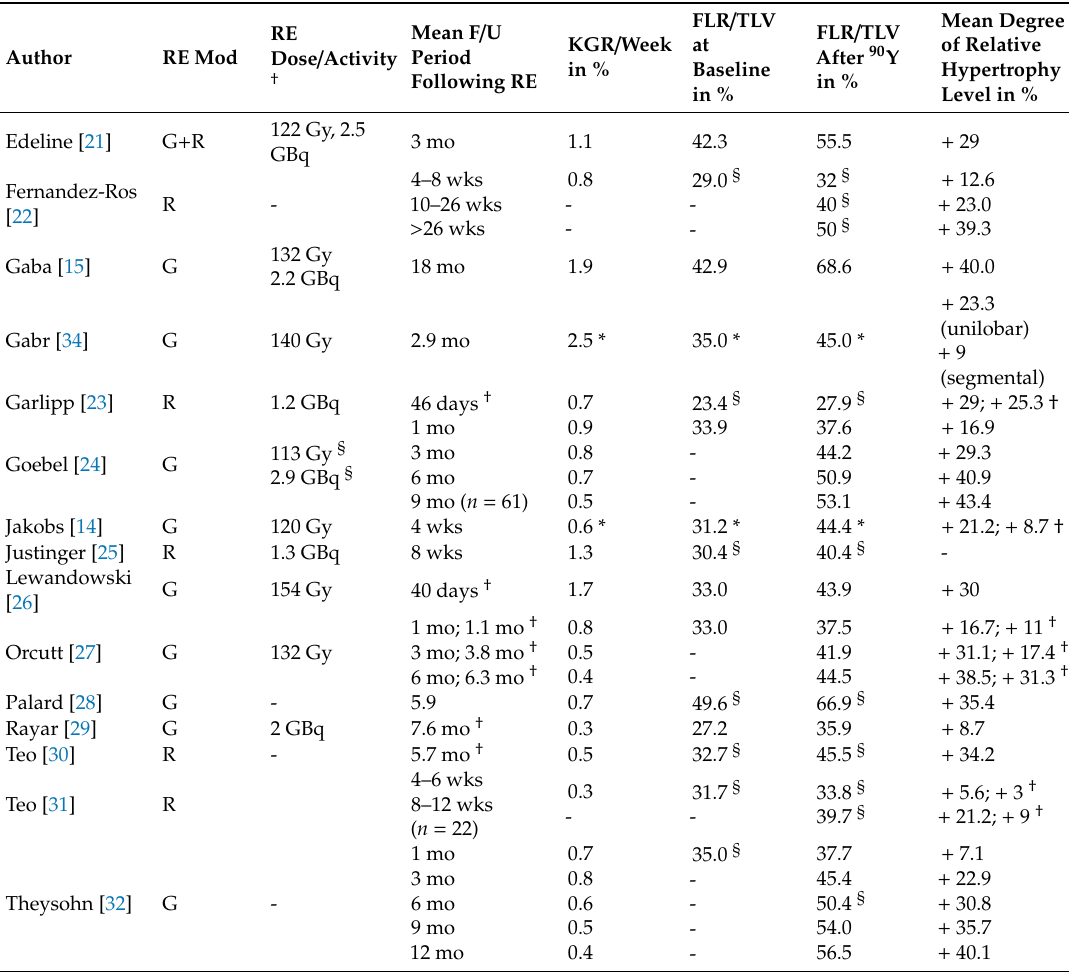
Table 2. Overview of radioembolization (RE)-induced